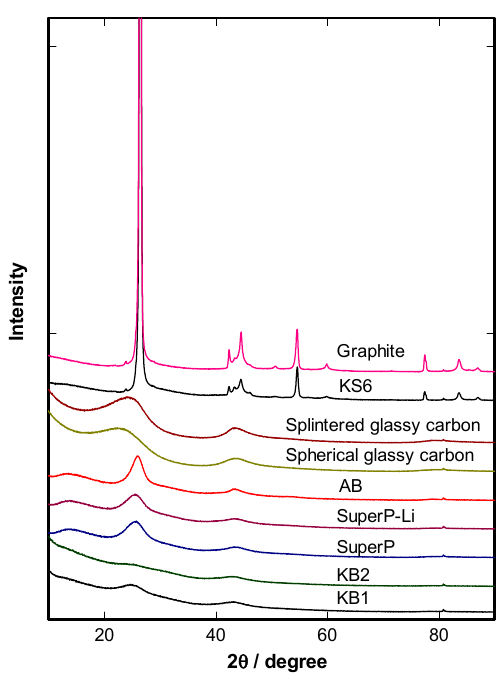
Figure 1. XRD patterns of different types of carbon.